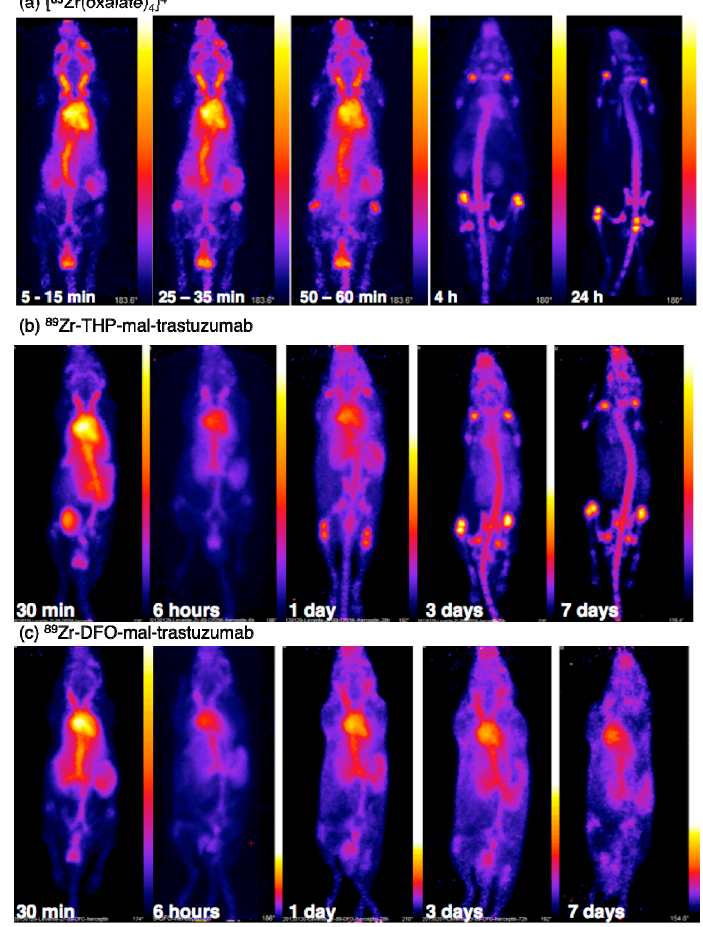
Figure 15. PET scans of C57Bl/6j mice administered: ( a ) [ 89 Zr(oxalate) 4 ] 4 − ; ( b ) 89 Zr-THP-mal-trastuzumab; and ( c ) 89 Zr-DFO-mal-trastuzumab. For the animal administered [ 89 Zr(ox) 4 ] 4 − 98% of the injected dose remains 4 h post-injection, and is associated predominantly with the skeleton. For the animal administered 89 Zr-THP-mal-trastuzumab, the skeleton is clearly visible from three days post-injection, indicative of dissociation of 89 Zr 4+ from THP-mal-trastuzumab over time. This is in marked contrast to the animal administered 89 Zr-DFO-trastuzumab, where the blood pool remains visible out to seven days post-injection. Reprinted with permission under a Creative Commons Attribution (CC-BY) License from Ma, M.T.; et al. Tripodal tris(hydroxypyridinone) ligands for immunoconjugate PET imaging with 89 Zr 4+ : comparison with desferrioxamine-B. Dalton Trans. 2015 , 44 , 4884–4900. Copyright Royal Society of